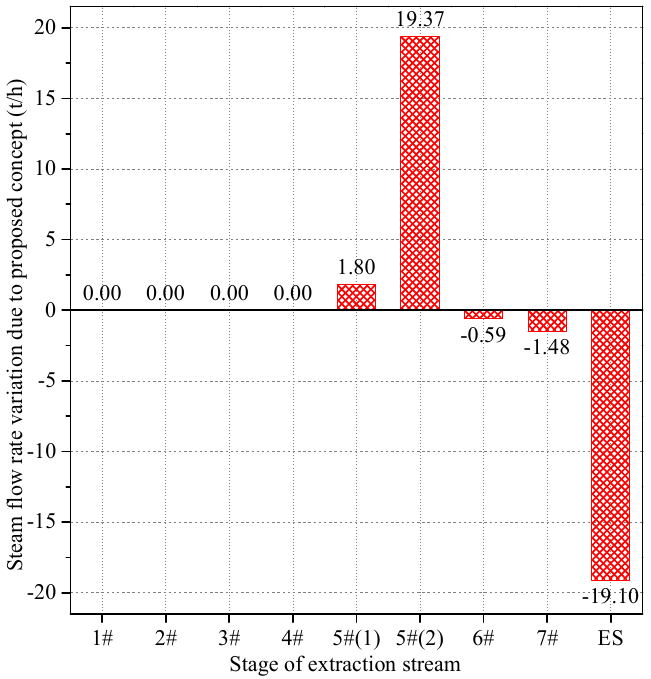
Figure 5. Flow rate variation of the extraction steam for each stage in the proposed unit compared with the original unit (5#(1) represents the 5# stage extraction steam into the supply-water heater; 5#(2) represents the 5# stage extraction steam into the low-pressure heater; ES represents the exhaust steam from the low-pressure cylinder).